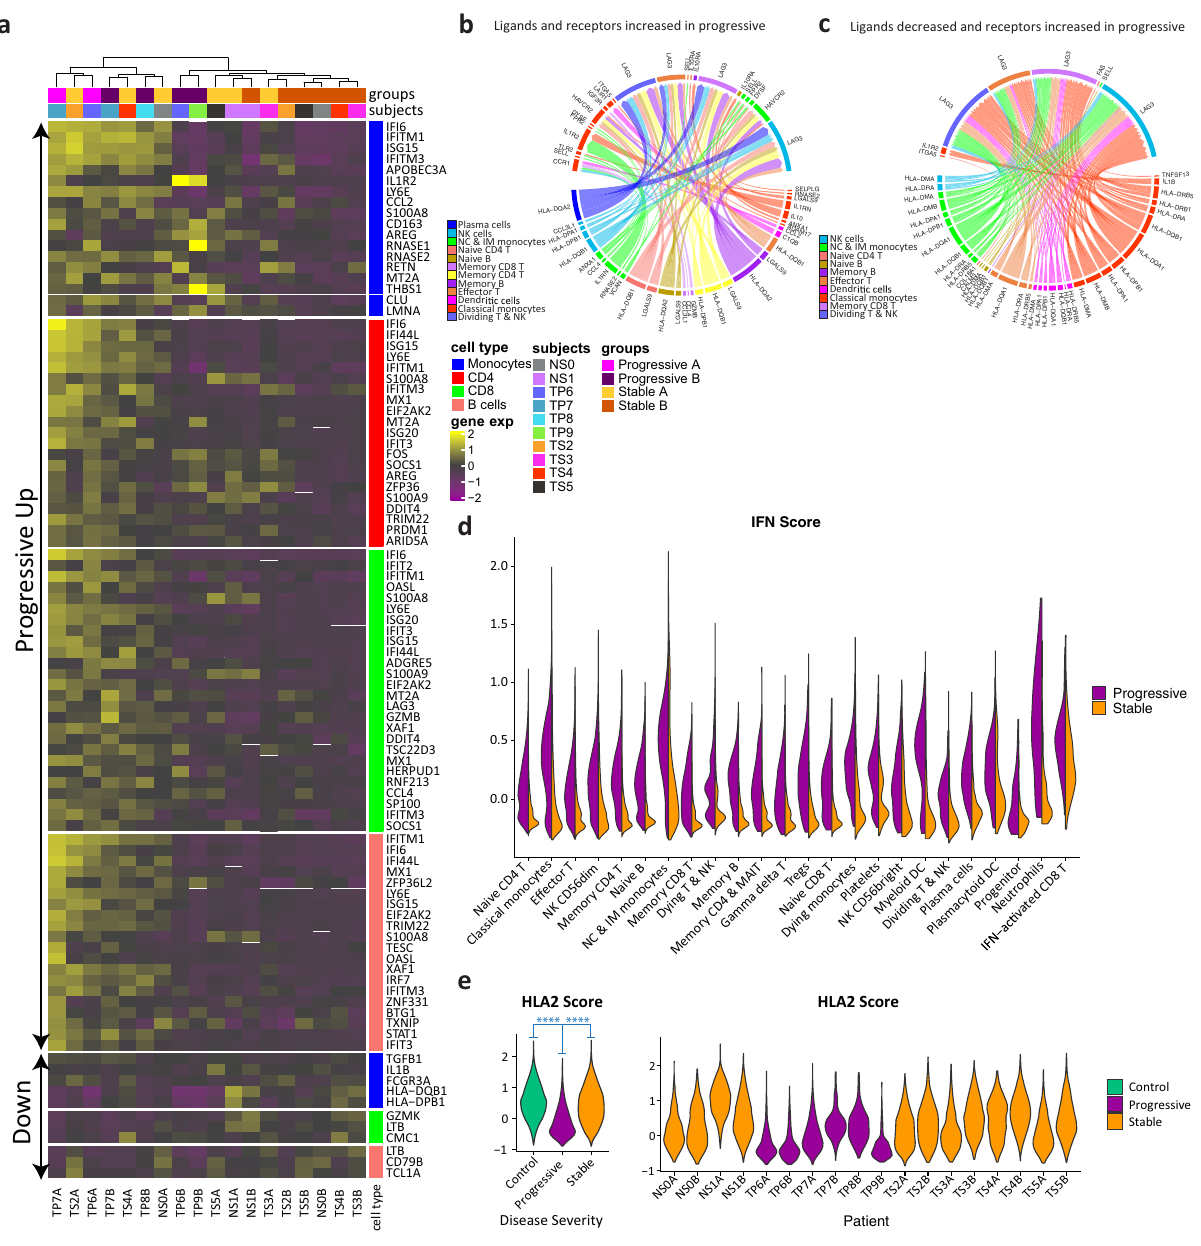
Fig. 3 Severe COVID-19 is associated with marked changes in gene expression and connectome. a Heatmap showing the top differentially expressed genes (logFC > 0.5, adjusted p -values < 0.05 calculated by Wilcoxon rank-sum test with Bonferroni correction for multiple comparisons) for each major cell type, comparing progressive to stable patients. The upper part of the heatmap depicts genes that are increased in progressive compared to stable patients (marked “ progressive up ” ). Hierarchical clustering separates most of the progressive samples from the stable ones based on gene expression similarities (except for some stable samples at time point A, which cluster with the progressive ones). b , c Differential connectivity maps (connectomes) of ligands (bottom half) and receptors (upper half). For each cell type, log-fold changes of ligands and receptors were calculated, comparing progressive to stable COVID-19 patients; we only plotted edges with >10% of cells expressing the ligand and receptor, and with an adjusted p -value < 0.05 for the comparison; edge size is proportional to the degree of change between progressive and stable patients. b Connectome of ligands and receptors that are both increased in progressive vs stable patients. c Connectome of ligands that are decreased and receptors that are increased in progressive vs stable patients. d A violin plot depicting differences in IFN-I score between progressive and stable COVID-19 patients in all PBMC subpopulations. e A composite score of nine HLA type 2 genes that are highly expressed in all subjects (HLA2 score) is decreased in monocytes of progressive patients relative to stable ones and controls. The right panel depicts the HLA2 scores of individual patient samples. **** p -value < 1E − 300 calculated by Wilcoxon rank-sum test. anti-in fl ammatory classical signaling in cells with high IL6R/ tocilizumab at a cellular level, our study was neither designed nor IL6ST (as observed in our myeloid cells) or pro-in fl ammatory powered to detect any clinical effect of the therapy. Nonetheless, trans-signaling in cells with low IL6R/IL6ST (non-myeloid cells), these gene expression patterns may suggest a link between possibly explaining the observed difference between cell types in tocilizumab effects, IL6R, IL6ST, and S100A8/9 in COVID-19 response to tocilizumab (Fig. 5e). While we detected a response to patients. NATURE COMMUNICATIONS| (2022) 13:440